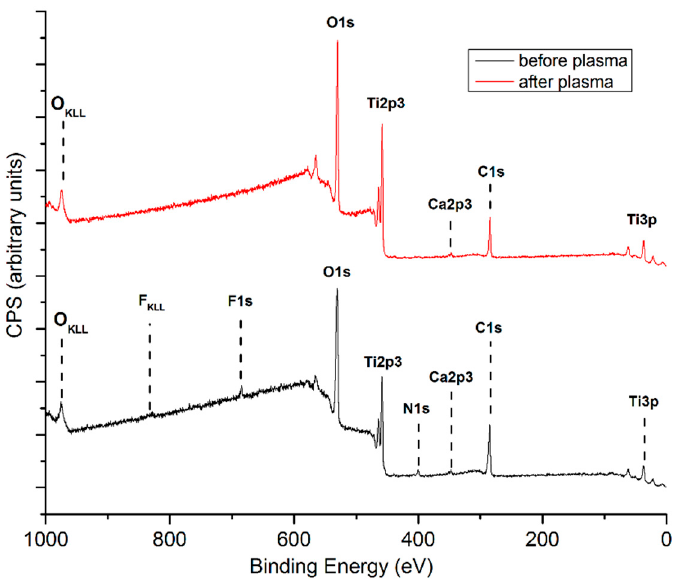
Figure 7. Wide XPS spectra of cTi before and after oxygen plasma treatment.